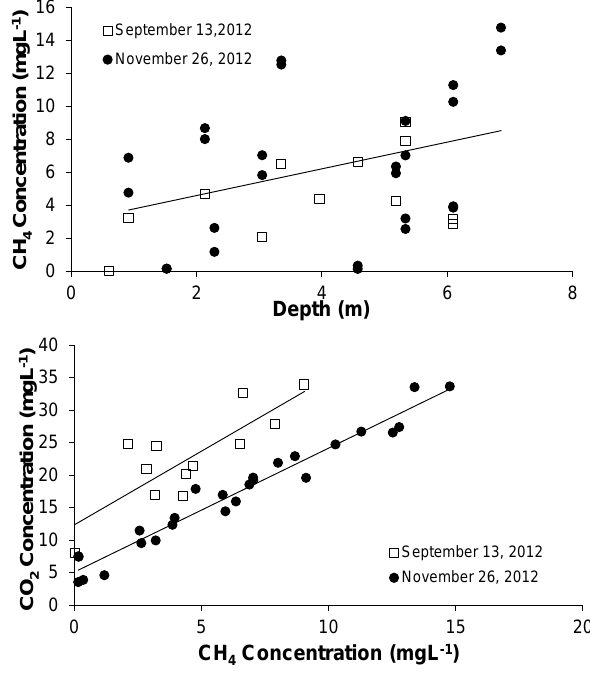
Fig. 4. Top: CH 4 concentrations versus depth. A weak correla- tion was found between depth and CH 4 concentrations ( R 2 =0.134, p =0.005). Bottom: CH 4 concentrations increase with increasing CO 2 concentrations for 13 September ( R 2 =0.667, p =0.0008) and 26 November 2012 ( R 2 =0.956, p